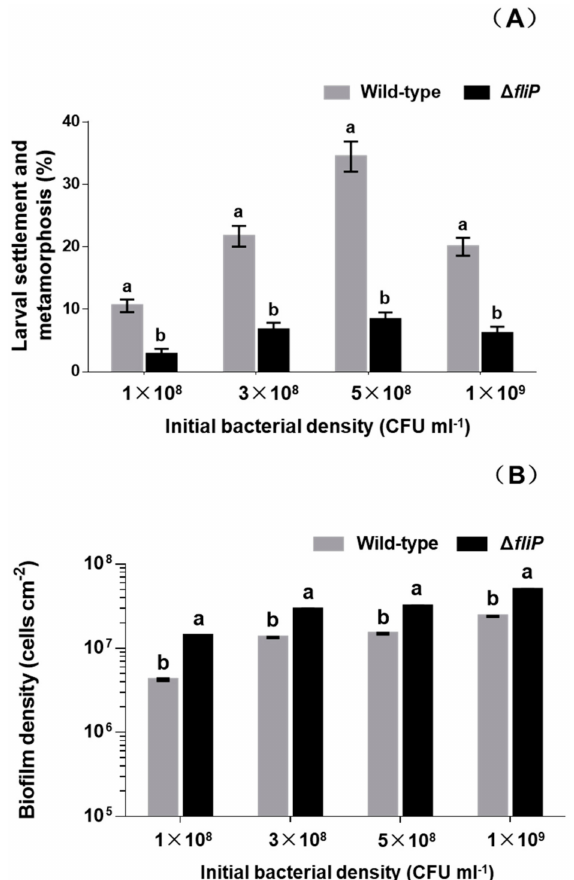
Figure 2. Relative to the wild-type strain the ∆ fliP strain reduced the inducing activity and increased bacterial density. ( A ) Inducing activities of biofilms on larval settlement and metamorphosis with di ff erent initial colony-forming unit (CFU); ( B ) biofilm density on glass slips with di ff erent initial CFU. Tested biofilms formed on the glass slips for 48